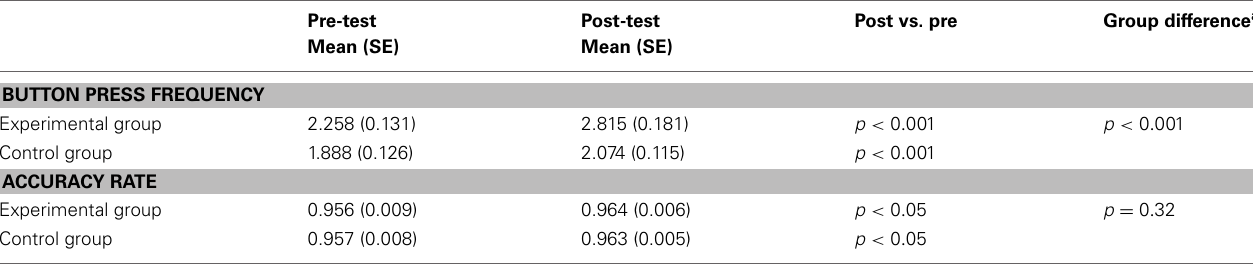
Table 1 | Behavioral performance in the experimental group and the control group before and after the rtfMRI